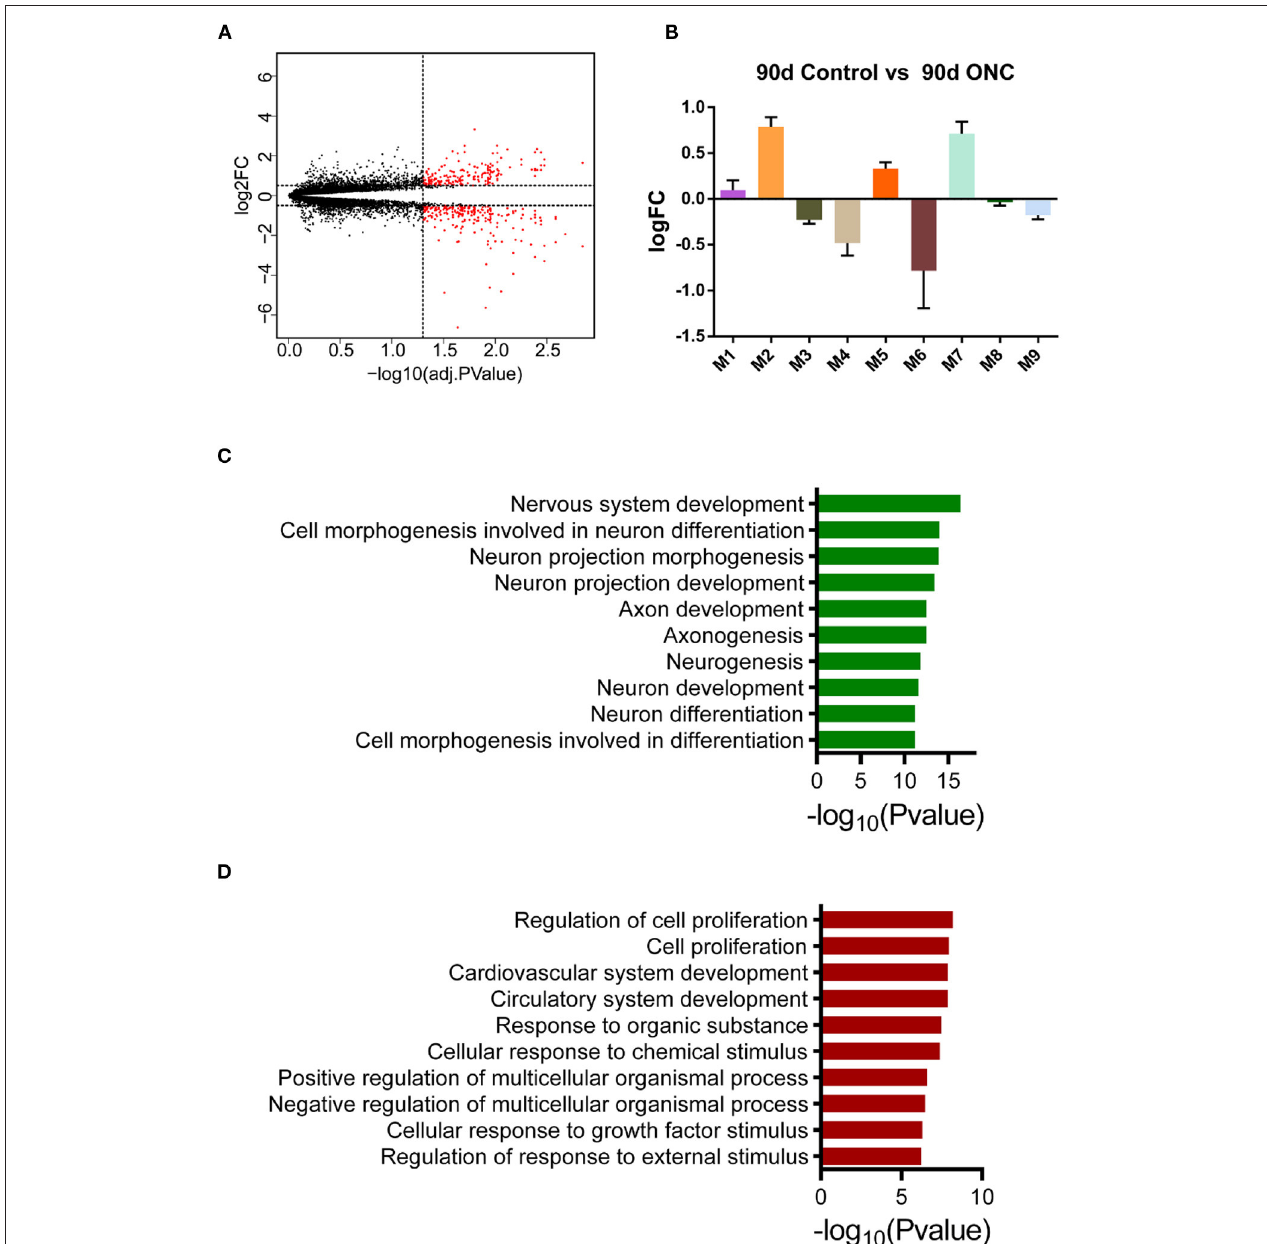
FIGURE 6 | Expression pattern of ONHs 90 d post-ONC. (A) Volcano plot of DEGs in ONHs 90 d post-ONC compared with uninjured control ONHs. Red points represent DEGs. (B) The changes in the average expression levels of the top 30 genes with the highest MM in ONHs 90 d post-ONC. (C,D) . GO enrichment analyses of genes with downregulated (C) and upregulated (D) expression showed the top 10 enriched biological processes. DEG, differentially expressed gene; ONC, optic nerve crush; ONH, optic nerve